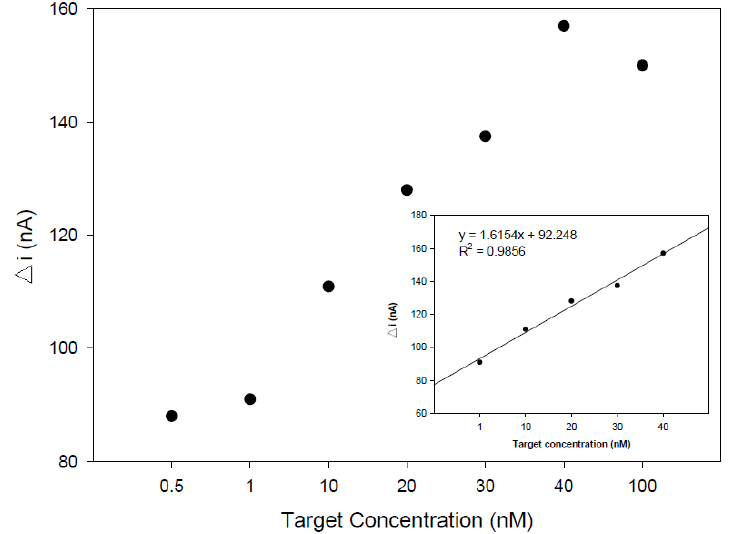
Figure 6. Plot of ΔI (difference of guanine oxidation signal of the probe-modified PGE in the absence and presence of the target) vs. target concentration. Inset: related calibration graph at concentration range 1–40 nM for complementary